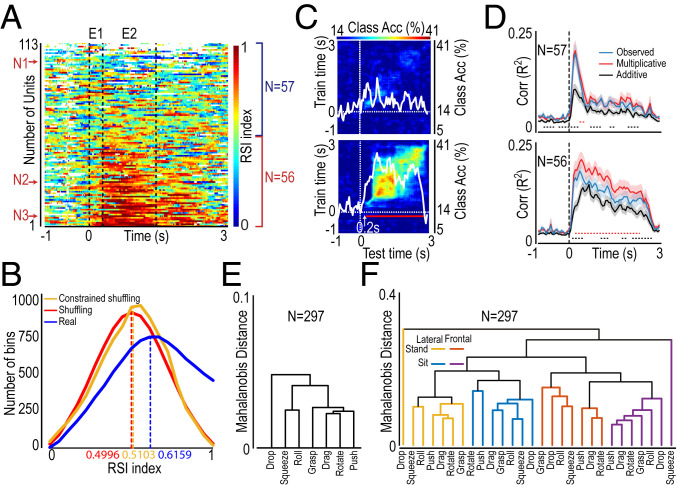
Stable and unstable OMA-selective units and clustering of OMA exemplars. (A) Time-resolved, across-format OMA rank stability index calculated for all OMA-selective neurons. For each bin, the color code represents the consistency across formats in the rank of the best OMA (rank 1) in the reference format (i.e., stand lateral). Units are arranged from Bottom to Top as a function of their total RSI score in epochs 1 and 2 (combined, greater on Bottom). We classified the first 56 units as stable and the last 57 as unstable. Labels of N1 to N3 (Left) indicate the position of the neurons (from 1 to 3) illustrated in Fig. 1C. (B) Frequency distribution of RSI values (in individual bins) obtained with real data, shuffling, and constrained shuffling of the data (Materials and Methods) during the interval corresponding to epochs 1 and 2, combined. Dashed lines represent the mean values of each distribution. (C) Format-independent decoding of OMA exemplars as a function of training and test time carried out on stable (n = 56) and unstable (n = 57) units defined based on RSI score (A). Conventions are as in Fig. 4. (D) Time-resolved correlation analysis between the multiplicative model (red), additive model (black), and observed data (blue) carried out on unstable (Top) and stable (Bottom) units, separately. Conventions are as in Fig. 3H. (E) Clustering of OMA exemplars based on the entire dataset, irrespective of the video presentation format. (F) Clustering of OMA exemplars based on the entire dataset, considering the video presentation format.